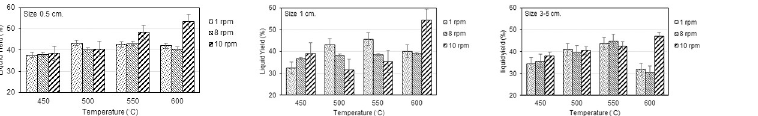
Fig 3. The effect of particle sizes of (a) 0.5 cm, (b) 1 cm, and (c) 3–5 cm on the liquid yields at varying temperatures and rotation speeds.